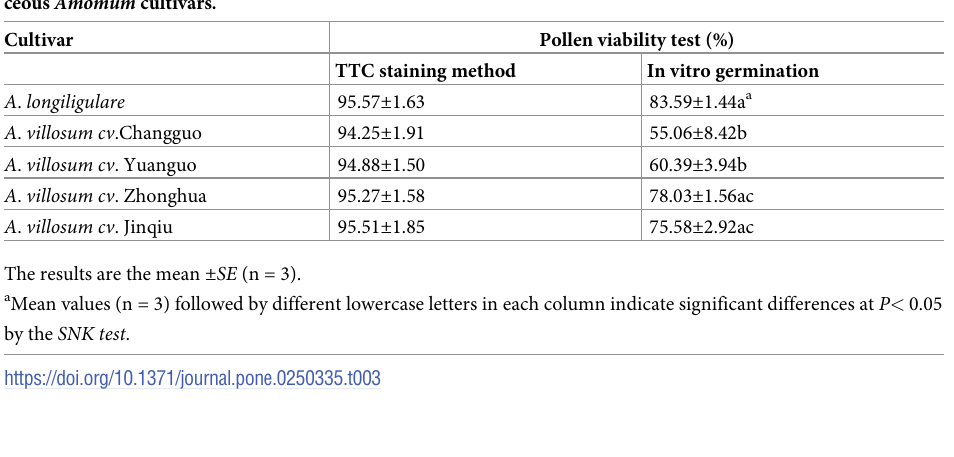
a Mean values (n = 18) followed by different lowercase letters in each column indicate significant differences at P < 0.05 by the SNK test . b Mean values (n = 18) followed by different uppercase letters in each column indicate significant differences at P < 0.05 by the Games-Howell test .